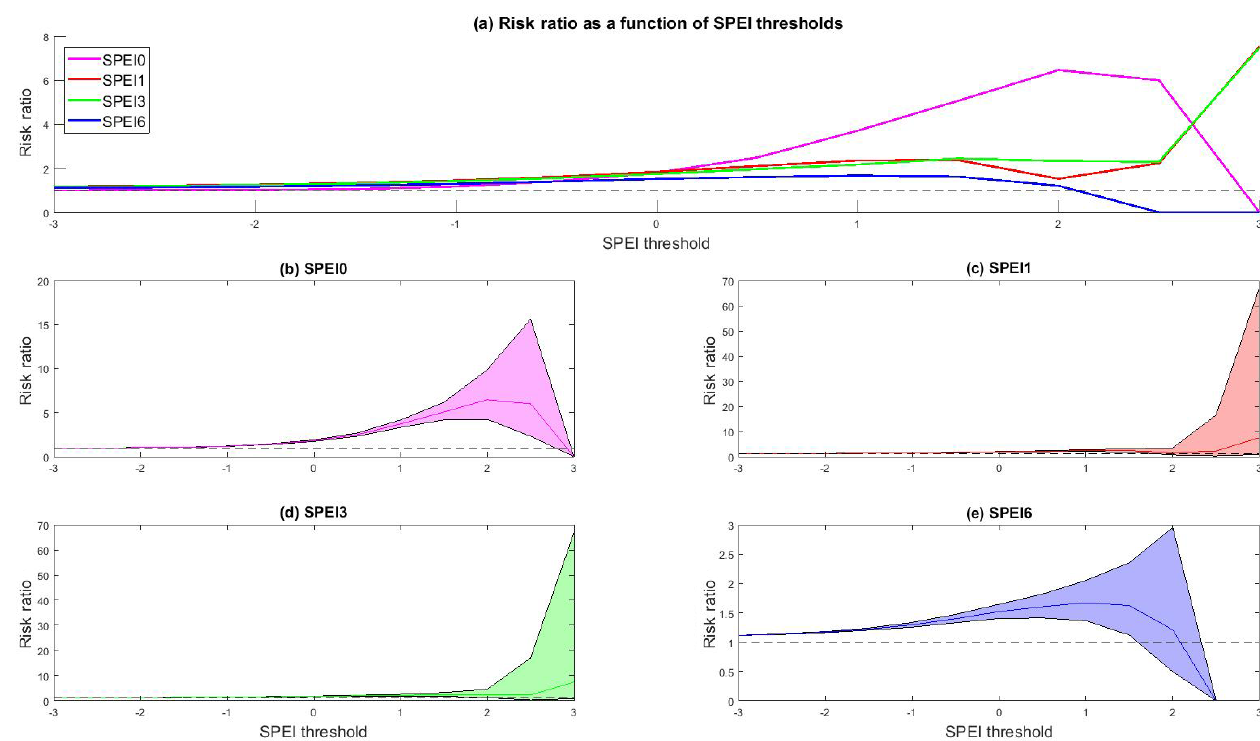
Figure 6. SPEI0 and seasonal-scale SPEIs for flood (F) and no-flood (NF) events.